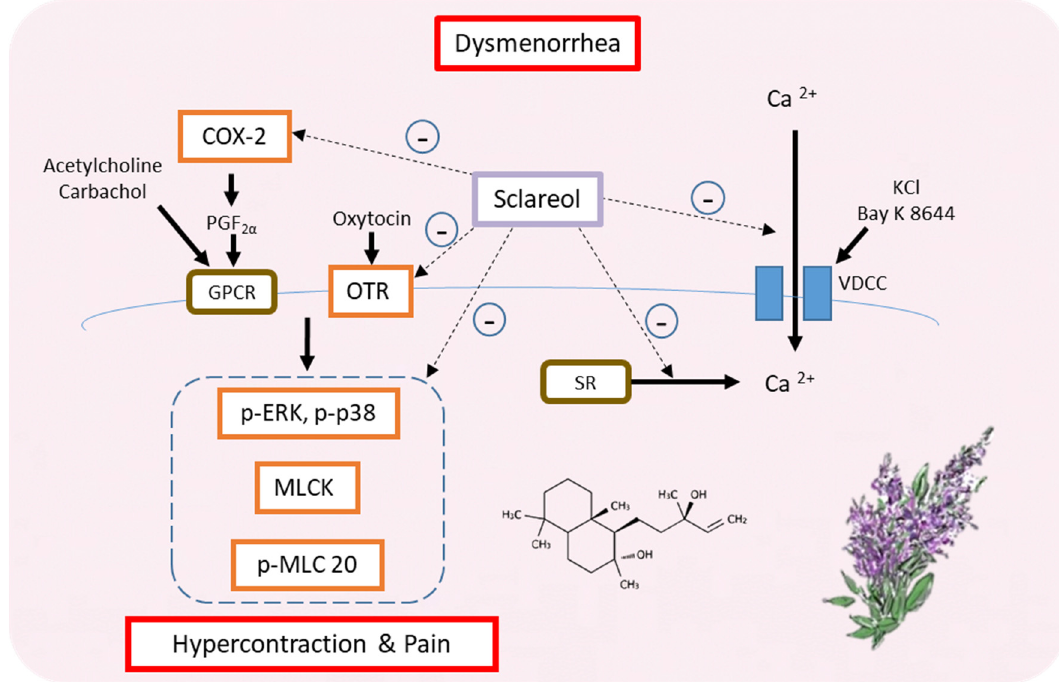
Figure 8. Possible model for the regulation of dysmenorrhea by sclareol in ex vivo and in vivo dysmenorrhea models. In summary, sclareol can downregulate the protein expression of OTR, MLCK, COX-2, p-ERK, p-p38, and p-MLC20 and can regulate the concentration of intracellular calcium, thus having the potential to regulate dysmenorrhea.